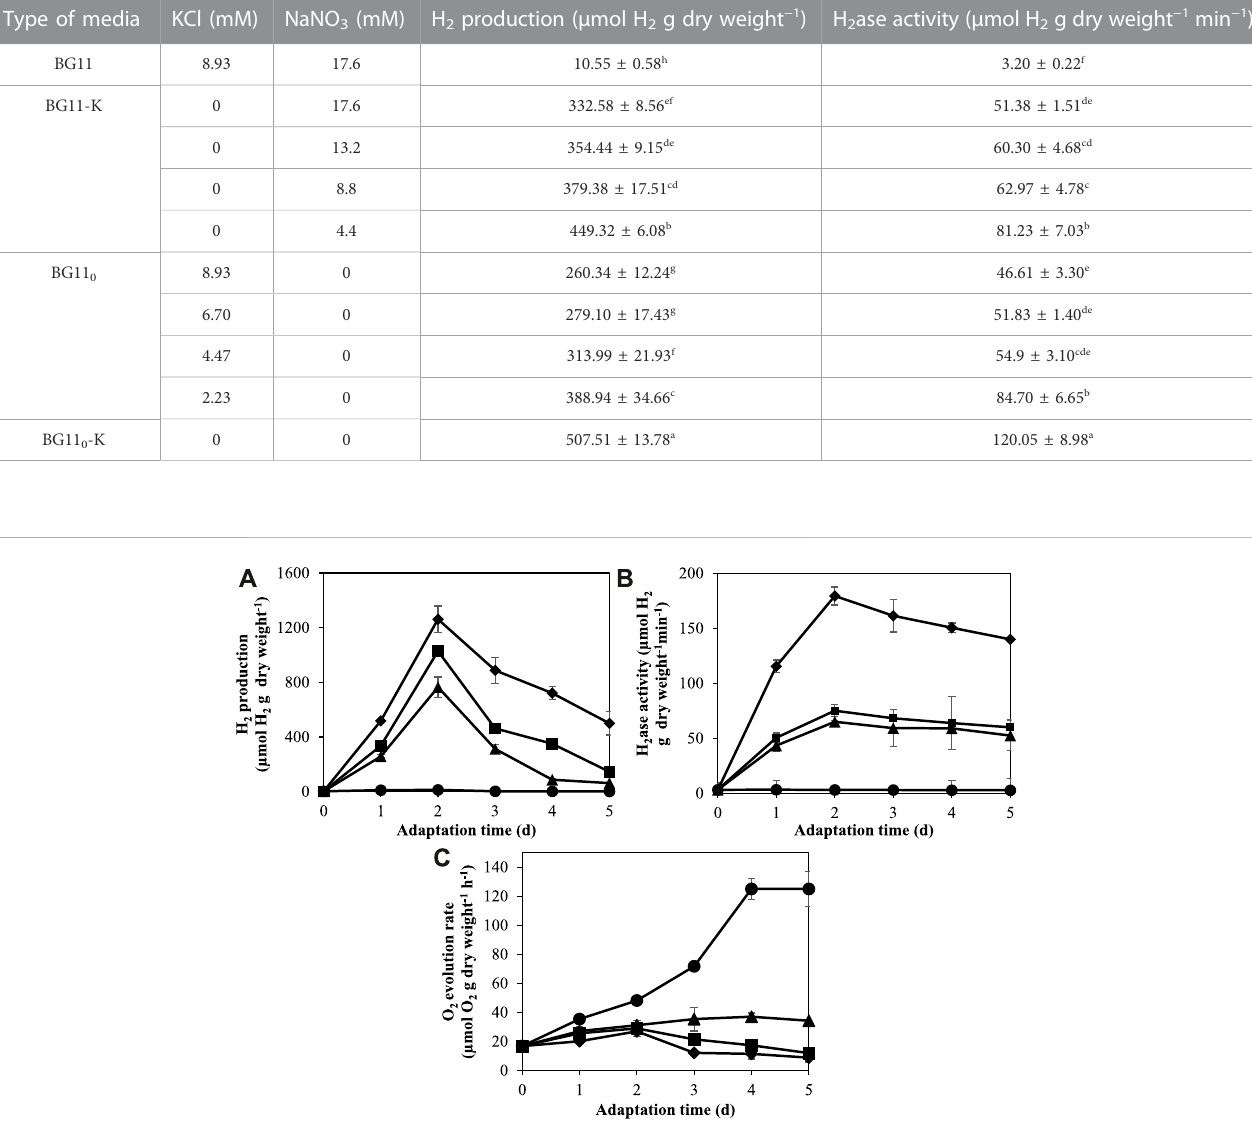
TABLE 1 H 2 production and H 2 ase activity by A. halophytica cells incubated in various types of media: BG11 supplemented with Turk Island salt solution (BG11), potassium-deprived BG11 supplemented with Turk Island salt solution (BG11-K) containing various concentrations of NaNO 3 , nitrogen-deprived BG11 supplemented with Turk Island salt solution (BG11 0 ) containing various concentrations of KCl, and potassium- and nitrogen-deprived BG11 supplemented with Turk Island salt solution (BG11 0 -K) for 24 h. Data are means ± SD ( n = 3). Different letters in columns indicate a signi fi cant difference, and the same letter indicates no signi fi cant difference according to Duncan ’ s multiple range test at p < 0.05.